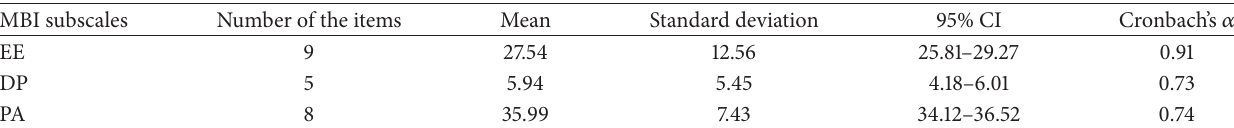
Table 2: Means, standard deviations, 95% confidence intervals, and internal consistency estimates on original subscales of the Maslach Burnout.